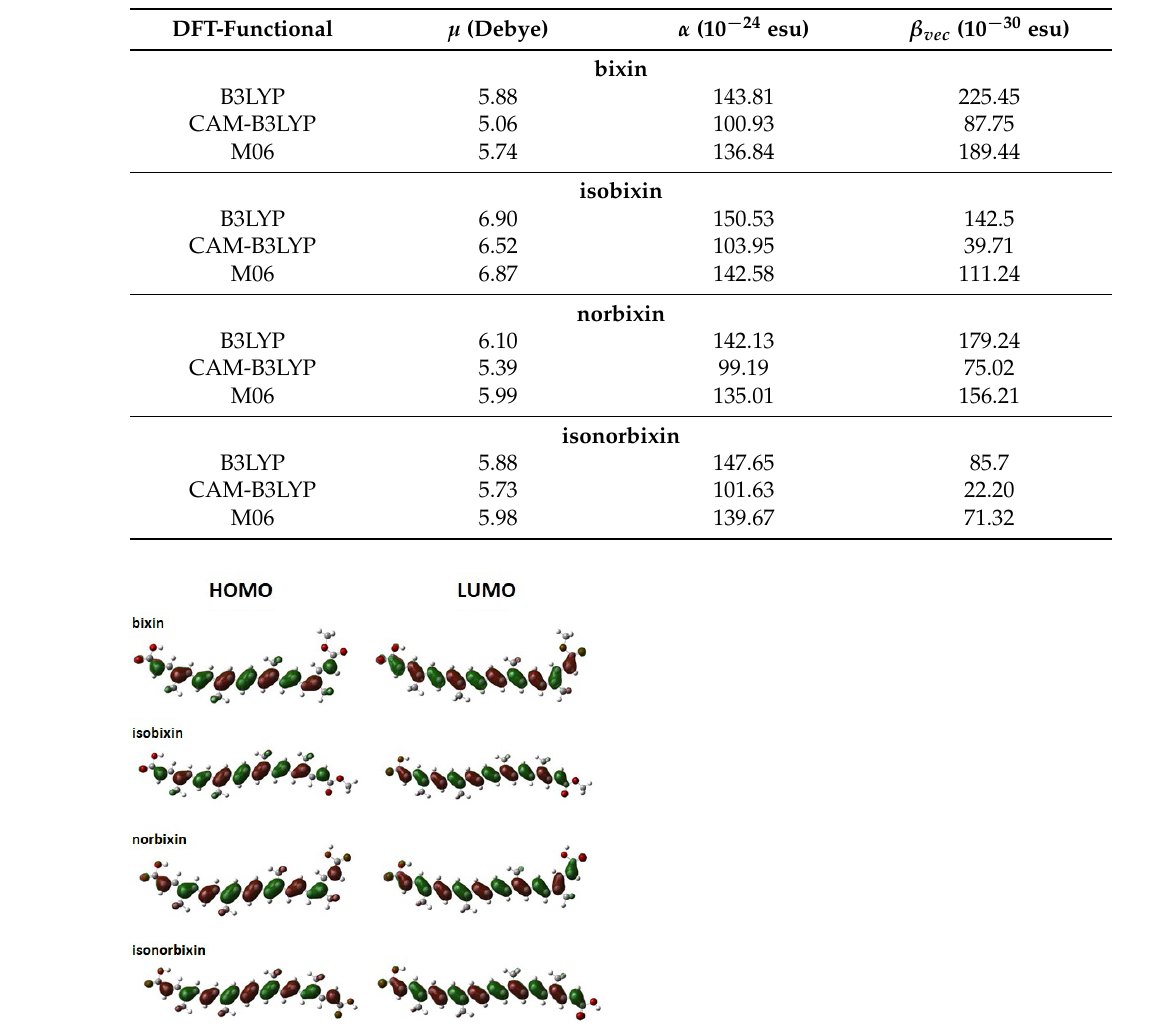
Table A16. Dipole moment ( µ ), average linear polarizability ( α ), and vector component of the first ( β vec ) hyperpolarizability of the dyes in chloroform solution. These results were obtained by employing the 6-31G(d,p) basis set.